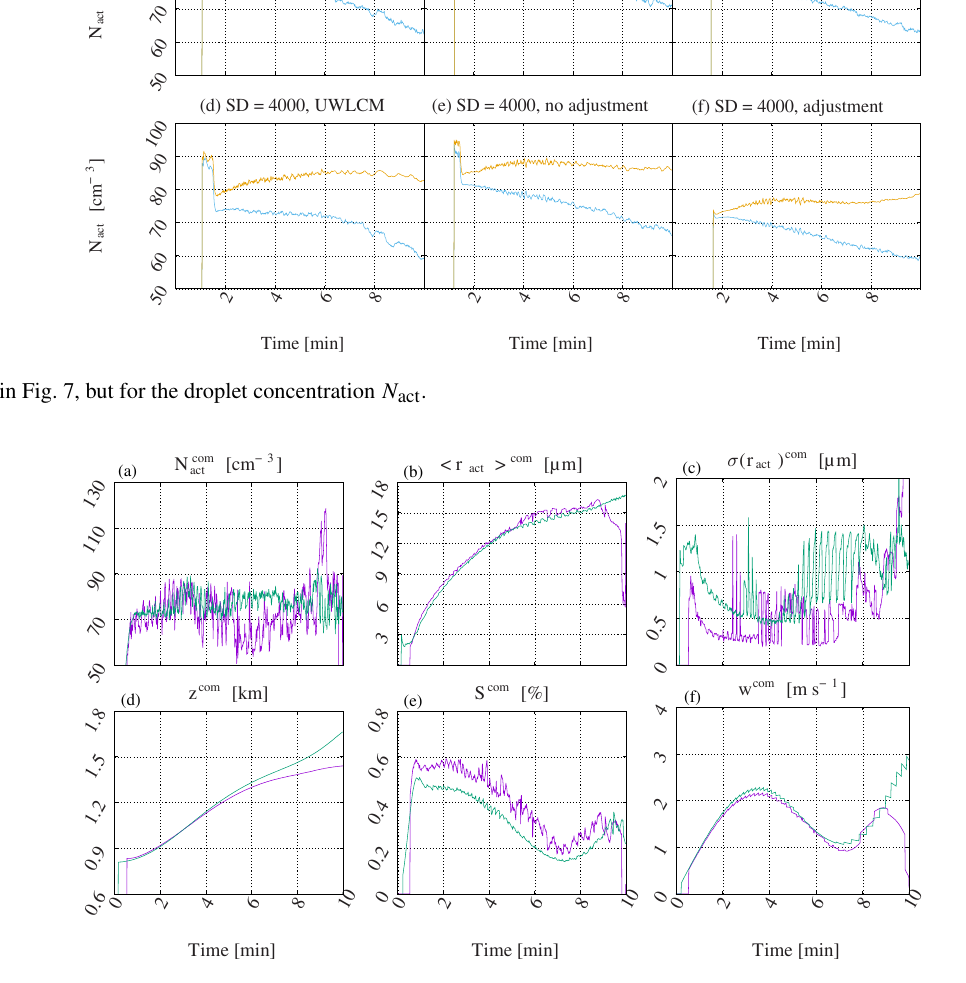
Figure 9. Evolution of various parameters at the center of mass of the cloud water in the rising thermal simulations applying 200 super- droplets (UWLCM; purple lines) or 200 divisions (Twomey scheme with adjustment; green lines). The panels show (a) droplet concentration, (b) droplet mean radius, (c) spectral width of the droplet size distribution, (d) height of the center of mass, (e) supersaturation, and (f) vertical